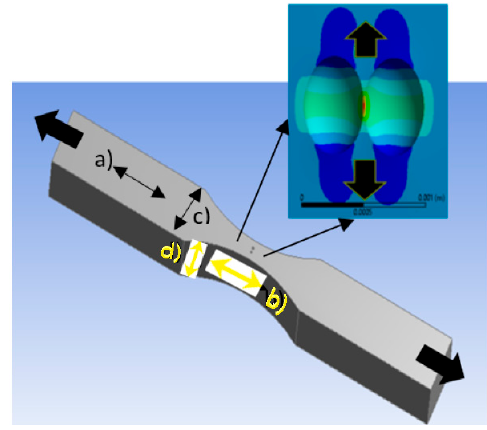
Figure 5. Specimen B—transverse pits.